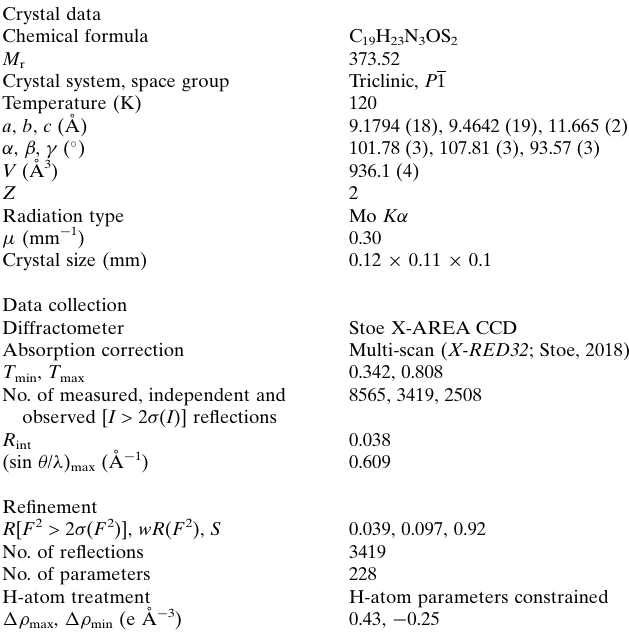
Table 2 Experimental details.